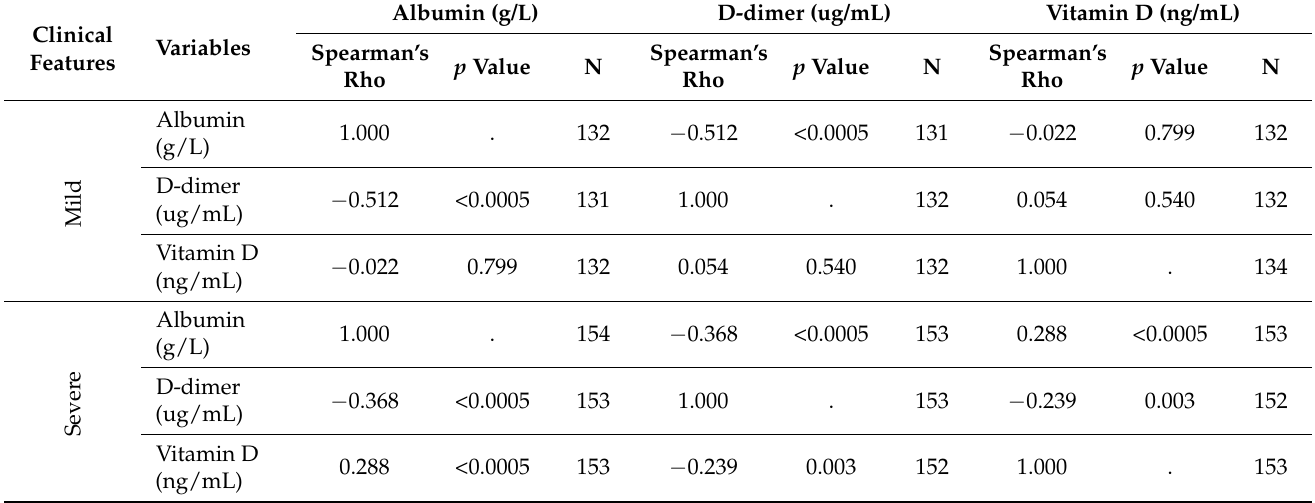
Table 2. Intercorrelations of examined biochemical parameters within groups of patients with mild and severe clinical pictures. The serum values of the examined biochemical parameters were obtained from blood samples immediately after admission to the hospital for treatment. Patients were divided into groups with mild (n = 134) and severe (n = 154) clinical pictures. Statistical significance was examined using the Spearman correlation coefficient. Values of p < 0.05 were considered statistically significant.